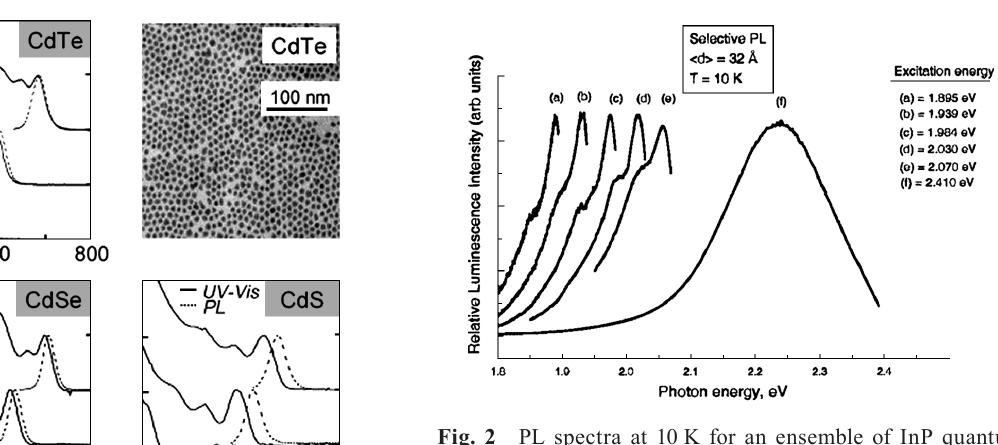
Fig. 2 PL spectra at 10 K for an ensemble of InP quantum dots with a mean diameter of 3.2 nm for different ex - citation energies. The first absorption peak of the QD ensemble is at 2.17 eV, so that the PL curves a–e re- sult from excitation (1.895–2.070 eV) in the red tail of the onset region of the absorption spectrum and are fluorescence-line-narrowing (FLN) spectra; curve f is a global PL spectrum since its excitation was at 2.14 eV and is well into the blue end of the first ab - sorption peak. Reprinted with permission from Mićić et al., “Size-Dependent Spectroscopy of InP Quantum Dots” J. Phys. Chem. B 1997 101(25), p. 4904–4912. Copyright 1997 American Chemical Society.